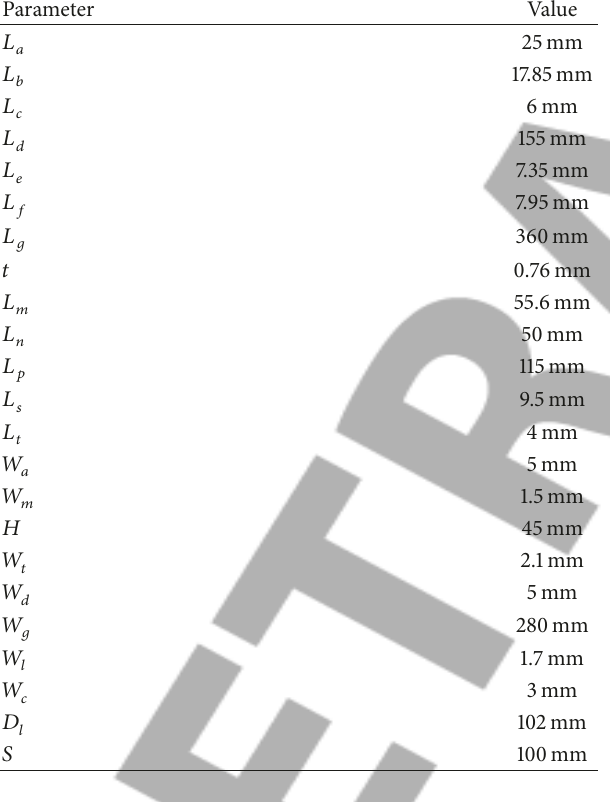
Figure 5: The simulation results of the gain of the antenna.